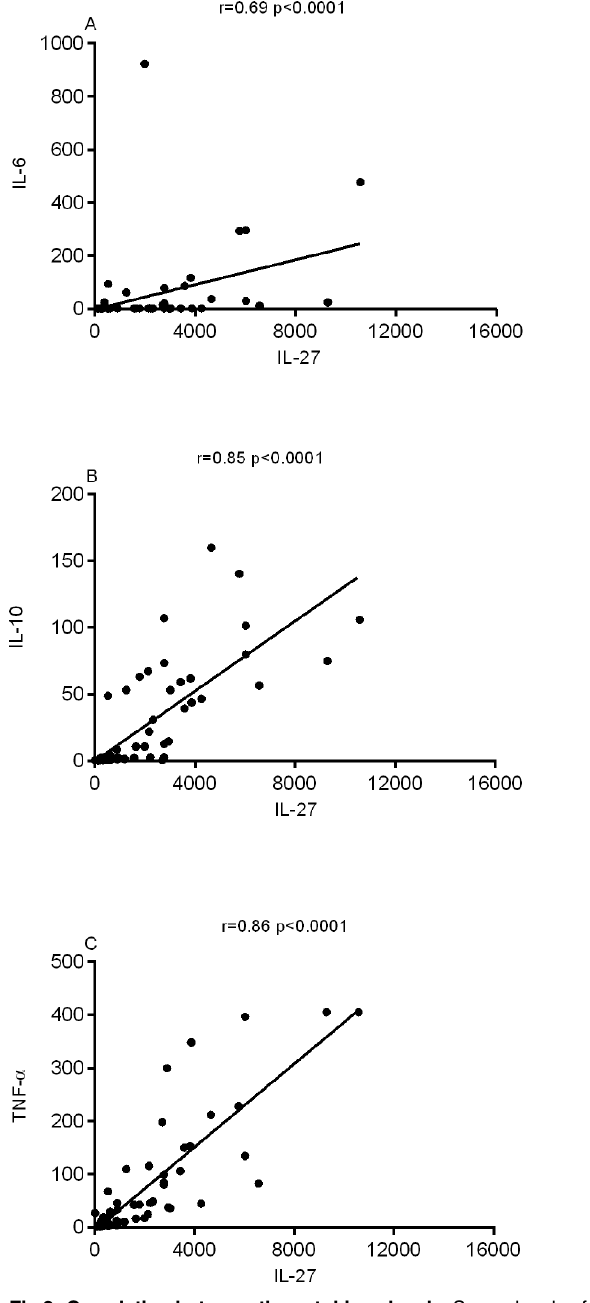
Fig 2. Correlation between the cytokines levels. Serum levels of IL-27, IL-6, IL-10 and TNF- α were measured in VL patients before treatment by Luminex assay. Correlation was observed between IL-27 with the cytokines IL-6 (A), IL-10 (B), TNF- α (C). Spearman correlation